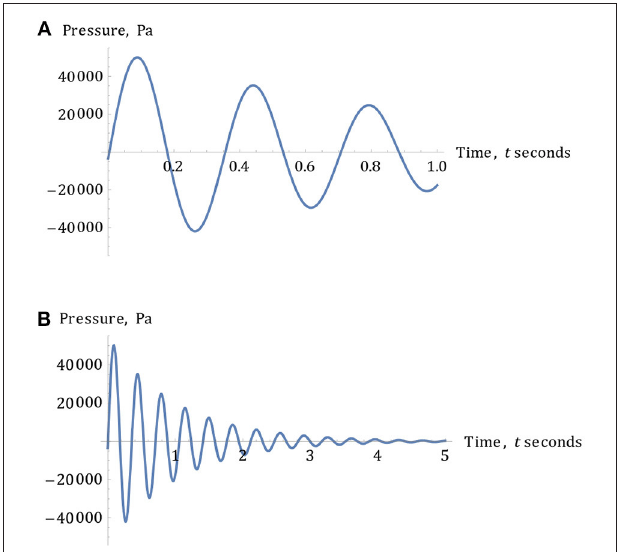
FIGURE 13 | (A) The variation of wave-pressure vs. time for a wave-velocity of 40m/s. (B) The variation of wave-pressure for a wave-velocity of 40 m/s over t the time interval of 0 5 s. Note the rapidly decreasing profile, complete ≤ ≤ with under-pressures and over-pressures.